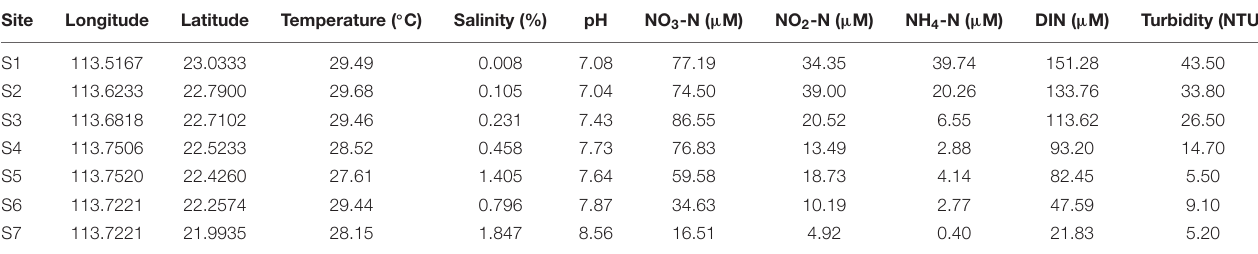
TABLE 1 | Environmental factor parameters of every sampling